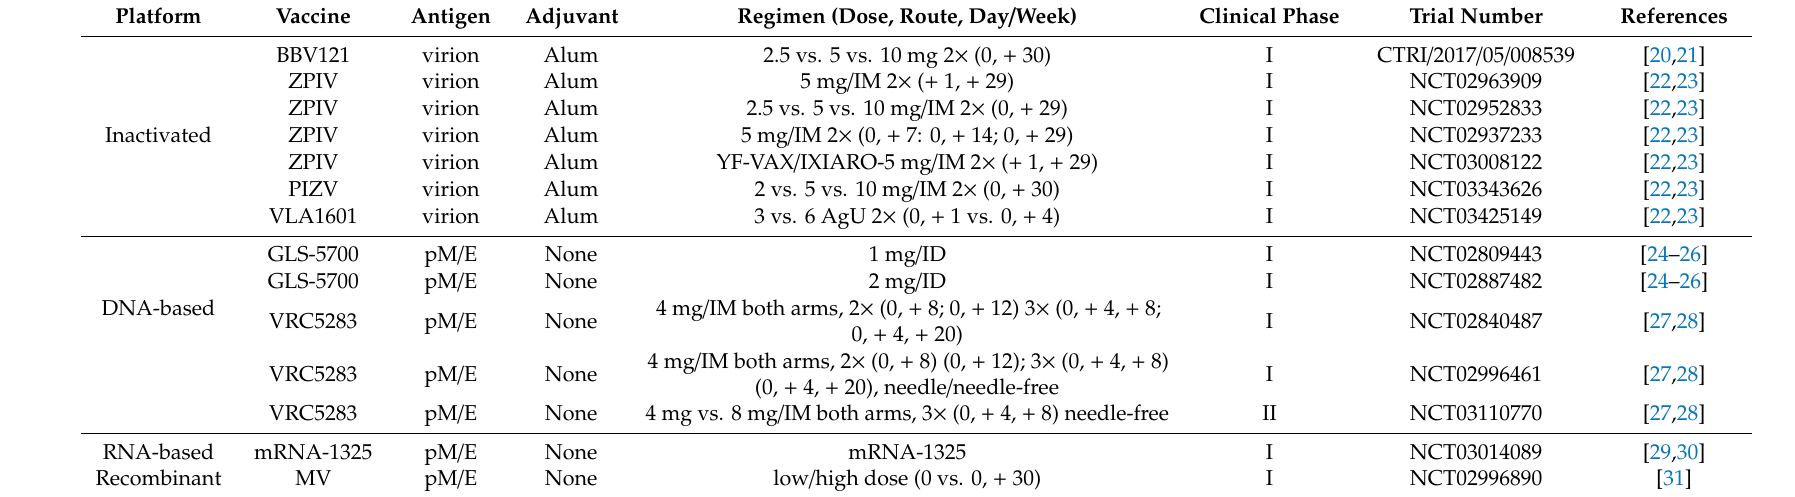
Table 1. Zika virus (ZIKV) vaccines clinical